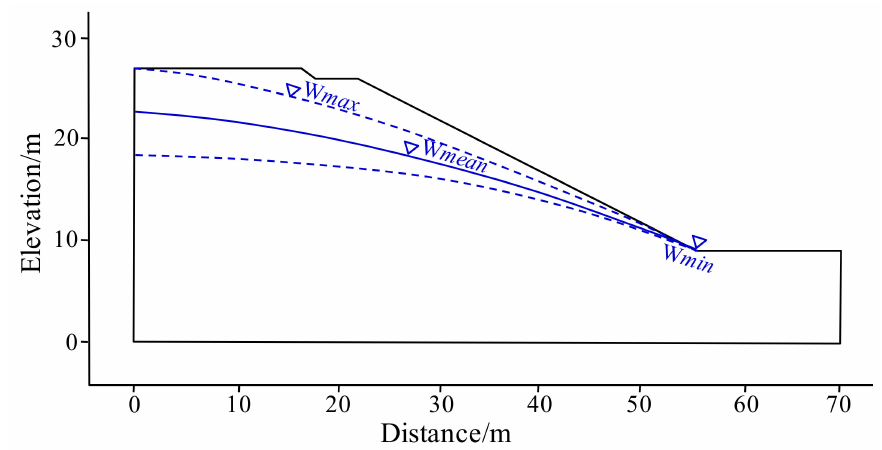
Figure 4. Geometric profile of the Lodalen slope. Table 2. Statistical properties of soil parameters for Lodalen